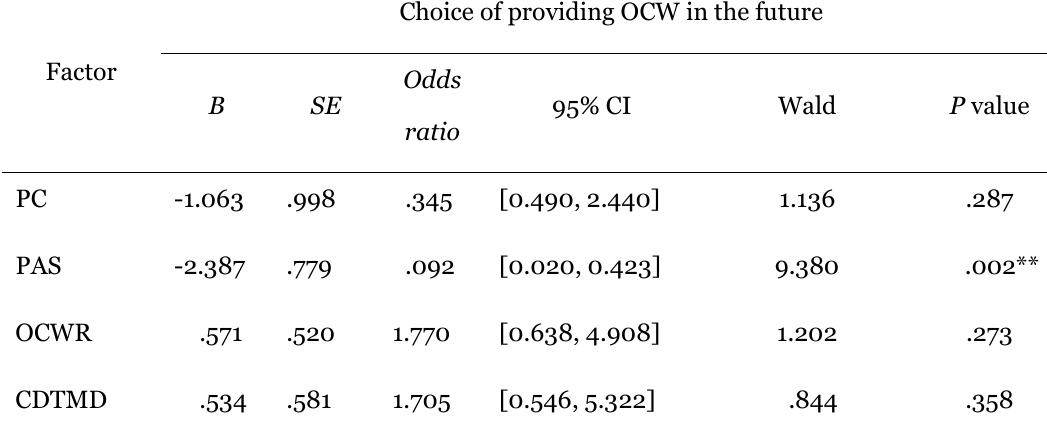
Logit Coefficients and Wald Statistics of the Proposed Logistic Regression Model Choice of providing OCW in the Factor